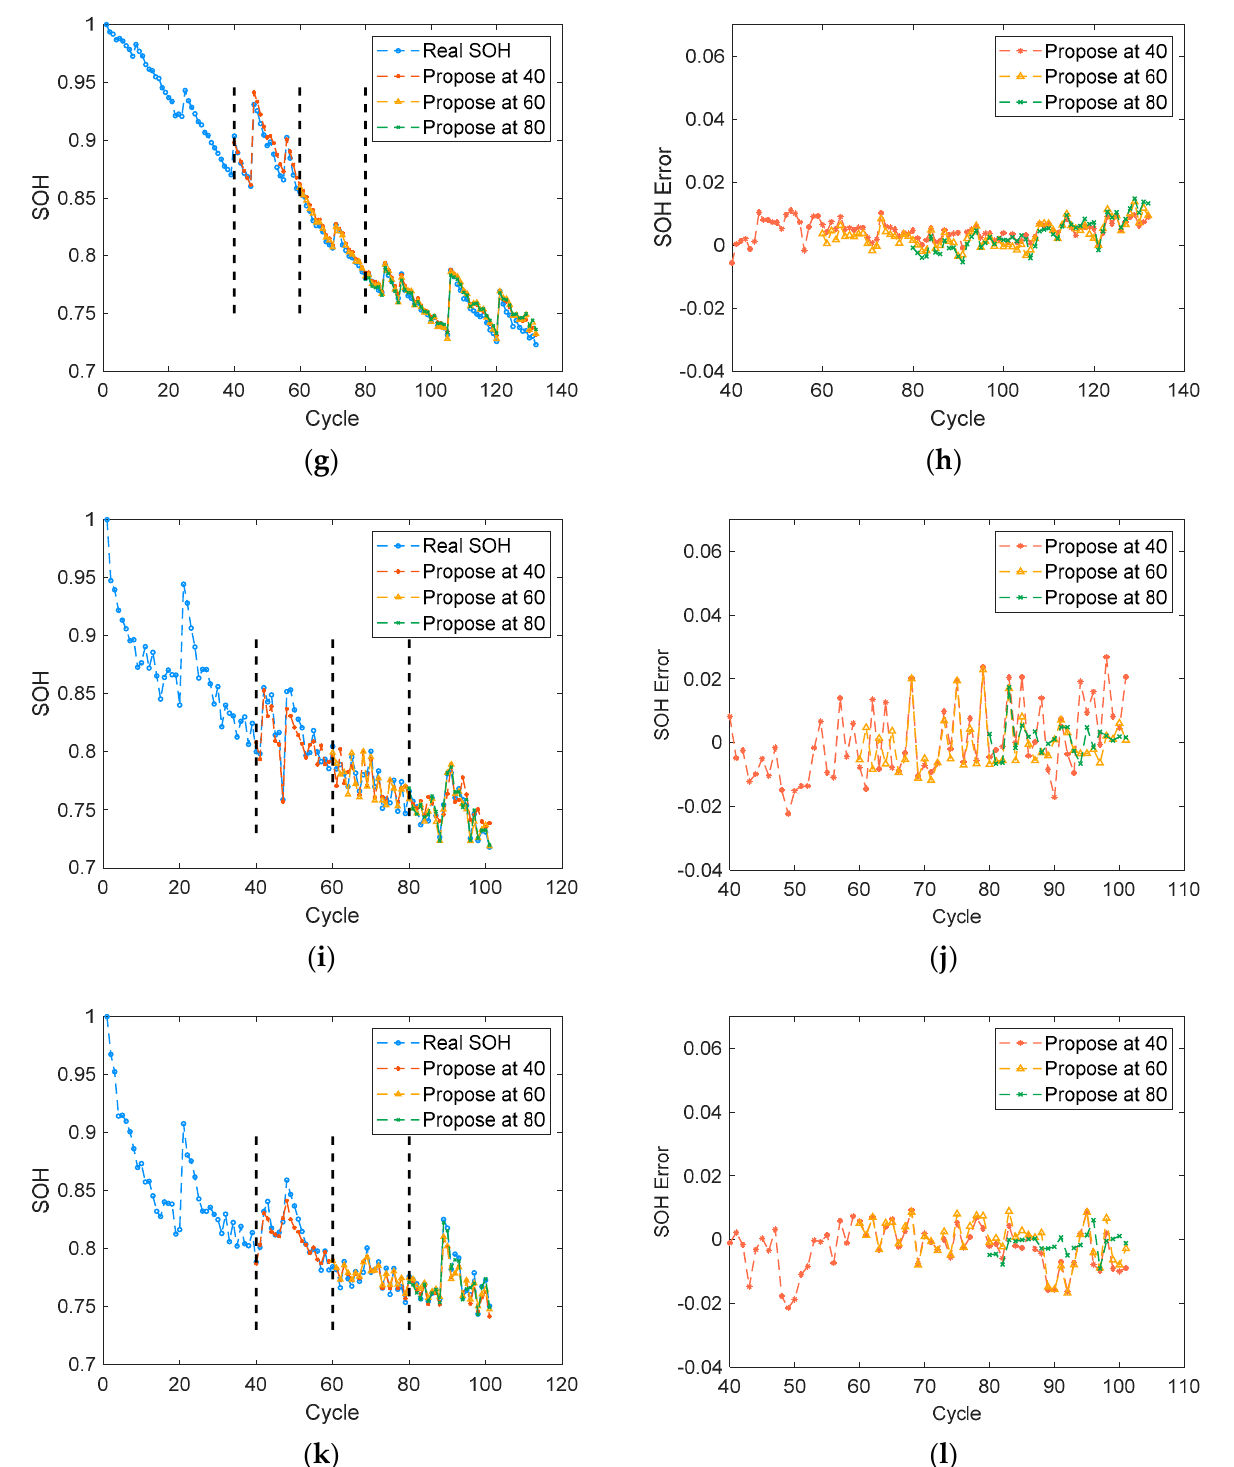
Figure 9. Prediction results on different testing batteries at different starting points; ( a , b ) #5; ( c , d ) #6; ( e , f ) #7; ( g , h ) #18; ( i , j ) #54; ( k , l ) #55. Table 3. Prediction RMSE and MAPE on comparisons for different starting points.